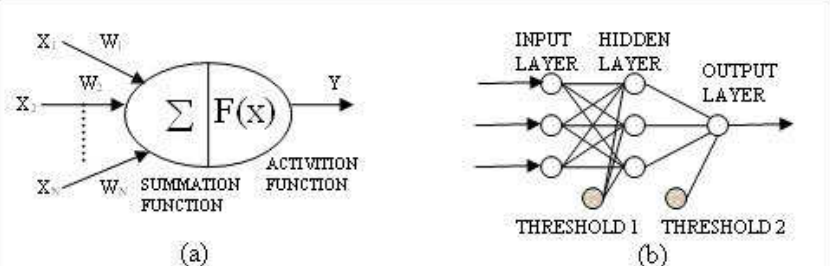
Figure 2. (a) Processing unit or neuron. (b) Architecture of a multi-layer feed-forward network with 3 units in the input layer, 3 units in the hidden layer and 1 unit in the output layer (3-3-1) and threshold units. Adapted from Rigol et al .